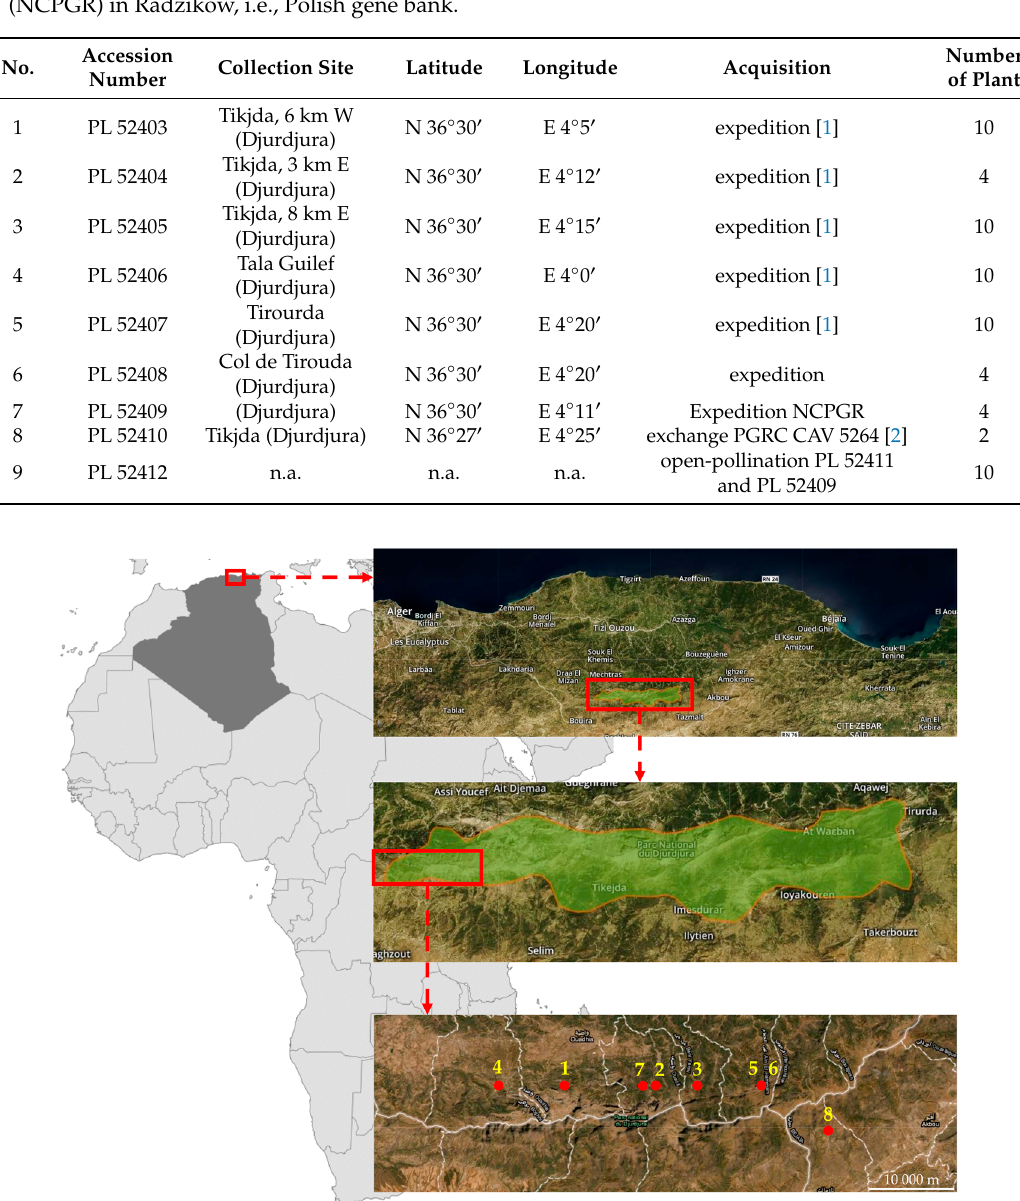
Figure 2. The Avena macrostachya Bal. ex Cross. et Durieu collection sites. Numbers indicating accessions according to Table 1. (UNEP-WCMC and IUCN (2020), Protected Planet: (protected area 4118; The World Database on Protected Areas (WDPA)) (On-line), (May 2020), Cambridge, UK: UNEP-WCMC and IUCN. Available at: www.protectedplanet.net.) Data available from the U.S. Geological Survey.